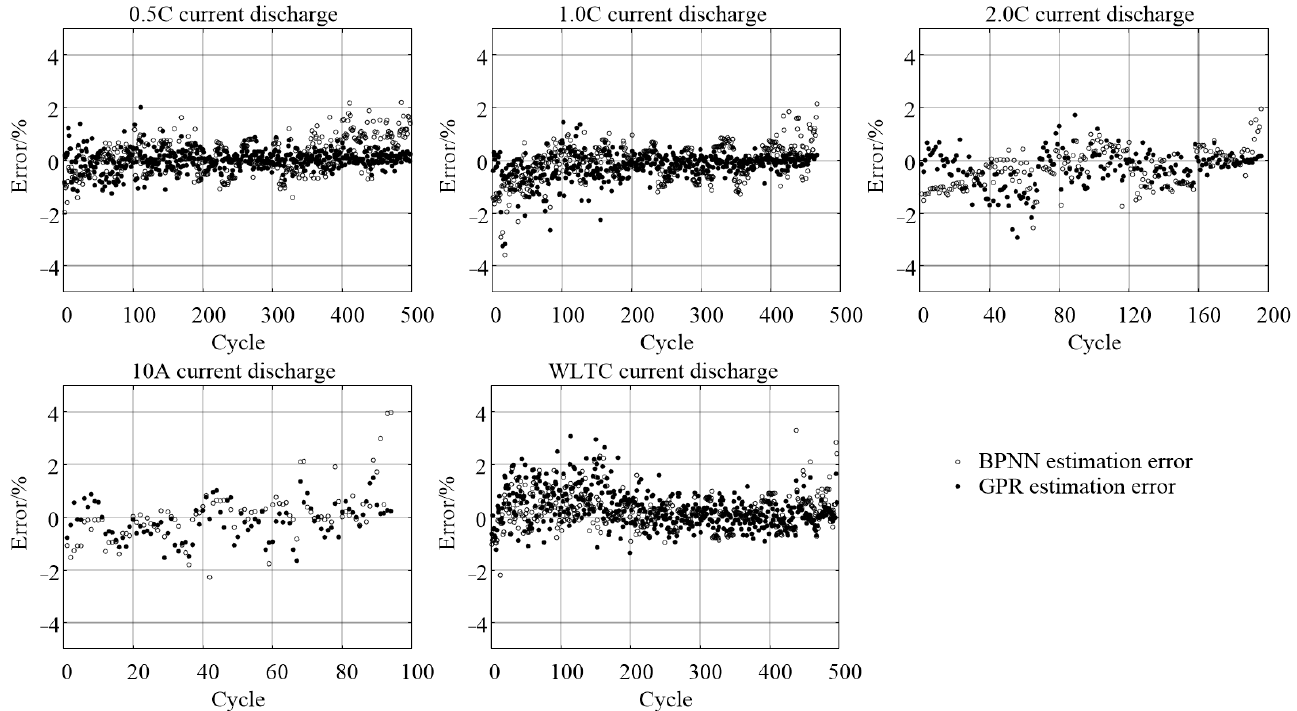
Figure 12. SOH estimation error comparison of BP neural network and GPR under different discharge conditions.